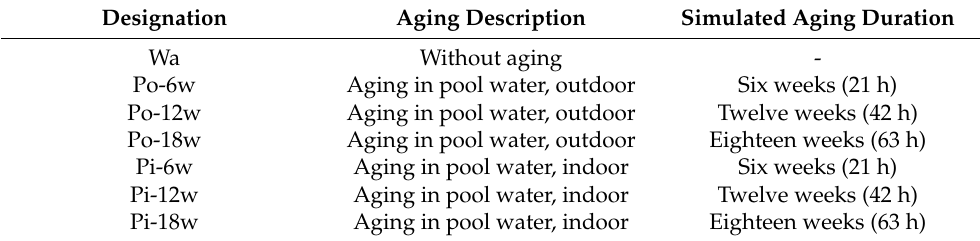
Table 2. The aging